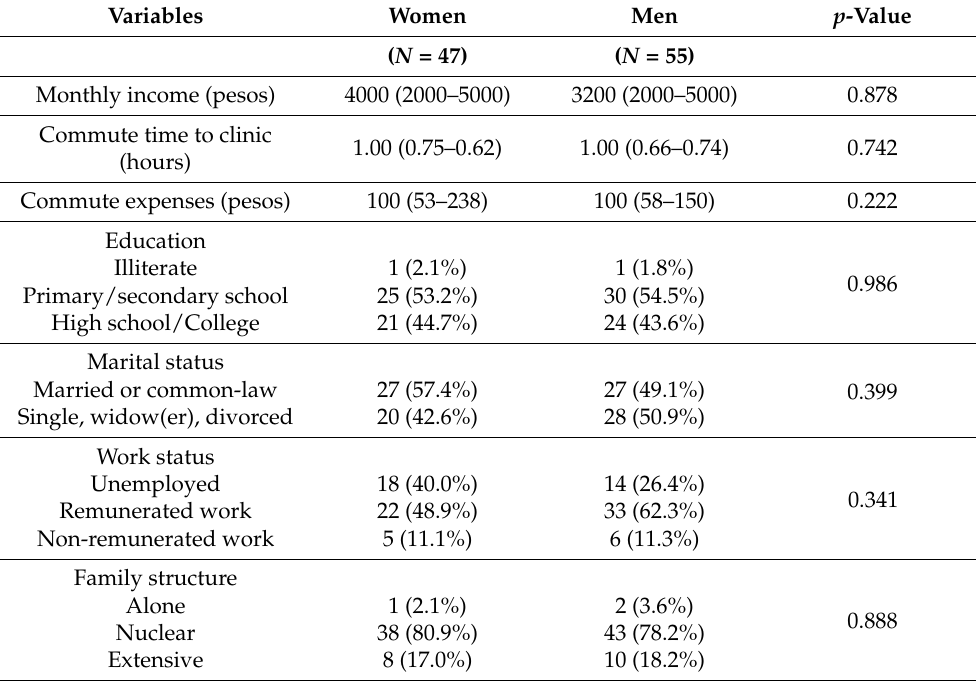
Table 2. Demographic characteristics of the study participants. Data are shown as mean ± standard deviation, median (percentile 25–percentile 75), or absolute frequency